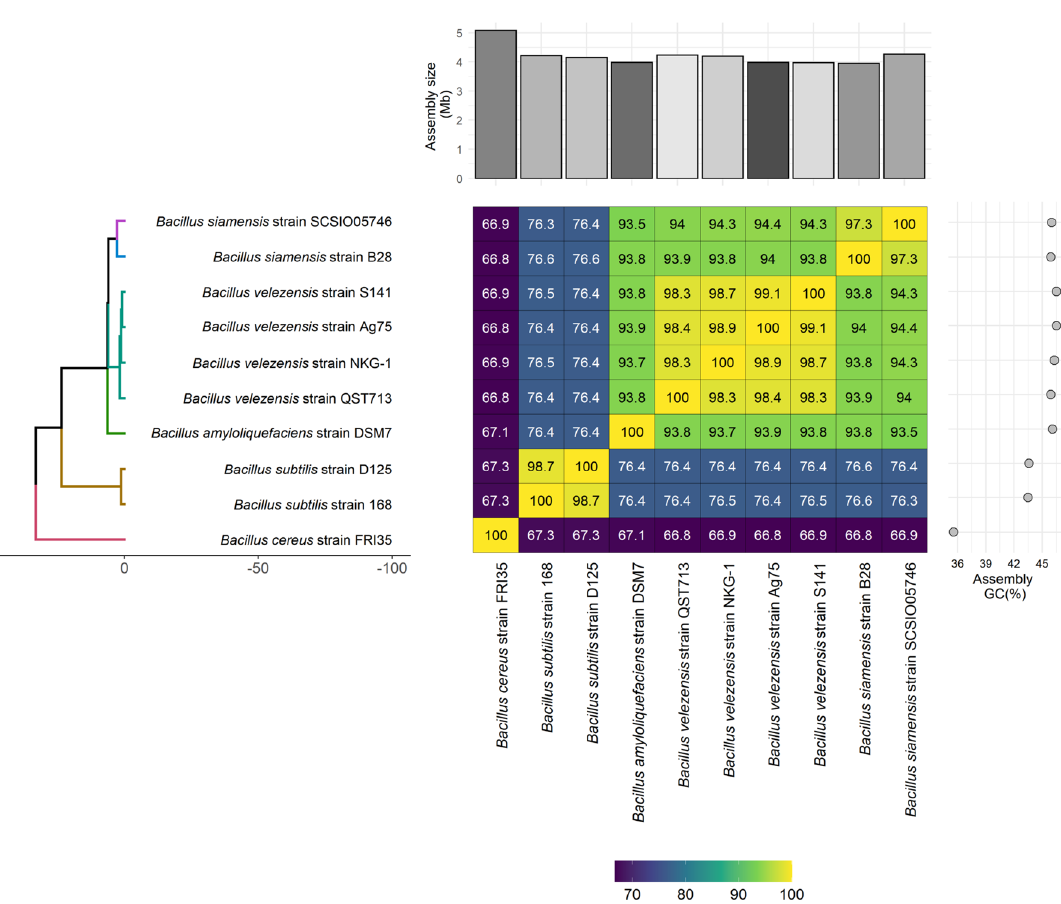
Figure 4. Phylogenetic tree based on maximum likelihood analysis using 10 available genomic assemblies of Bacillus velezensis , Bacillus siamensis , Bacillus amyloliquefaciens , Bacillus subtilis , and Bacillus cereus with heatmap annotation. The mean nucleotide identity (ANI) values (%) are displayed on the heatmap, ranging from lowest (violet) to highest sequence identity (green–yellow), grouped according to the phylogenetic tree. The heatmap was annotated with a bar graph showing the varying sizes (Mb) of all 10 assemblies (on the top) and their respective GC content (%) (right